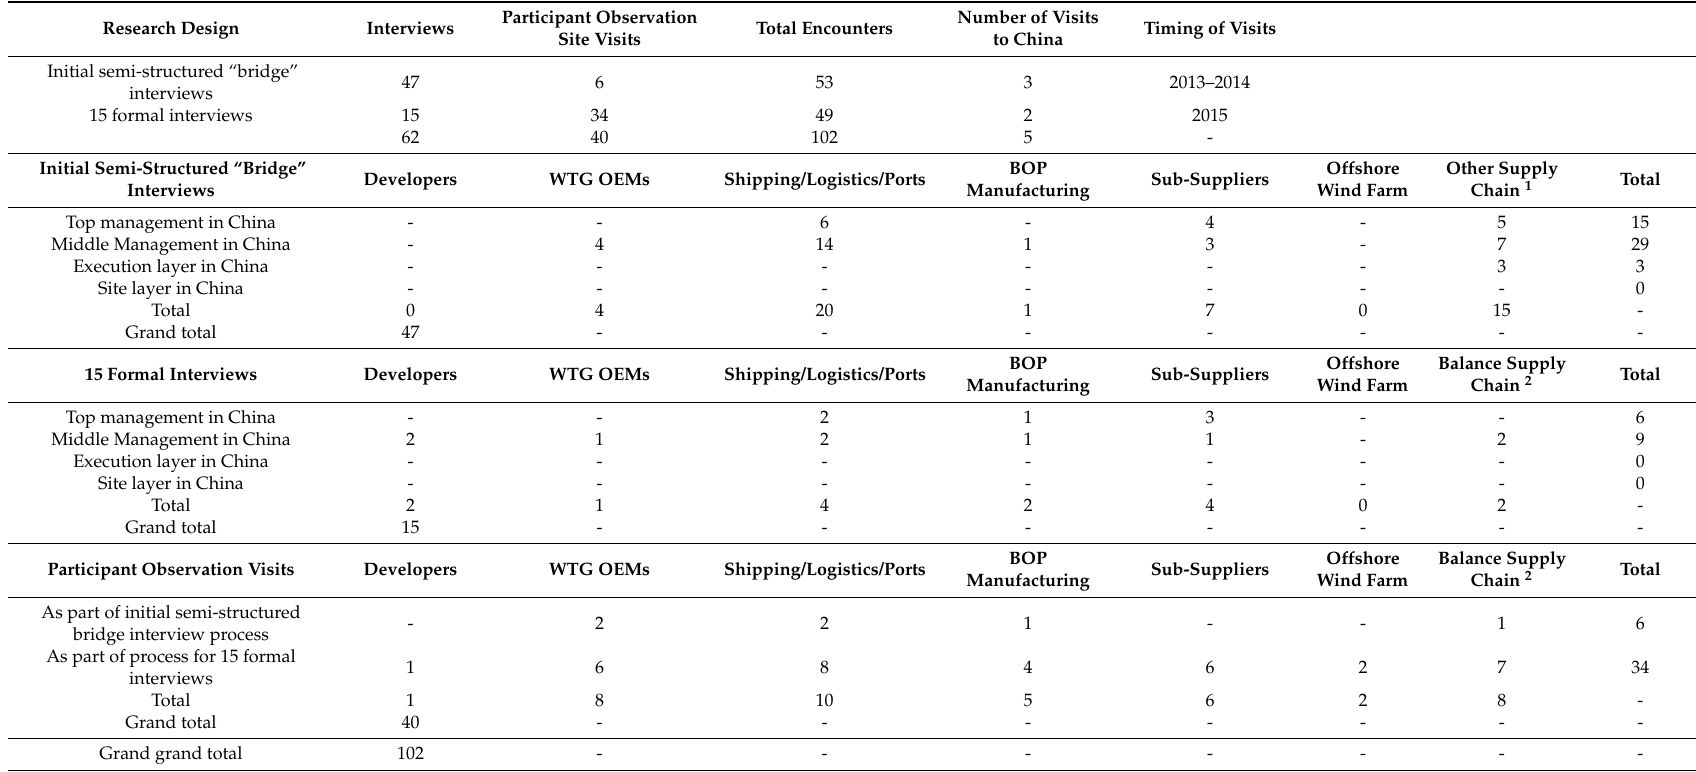
Table 3. Primary empirical data collection efforts in